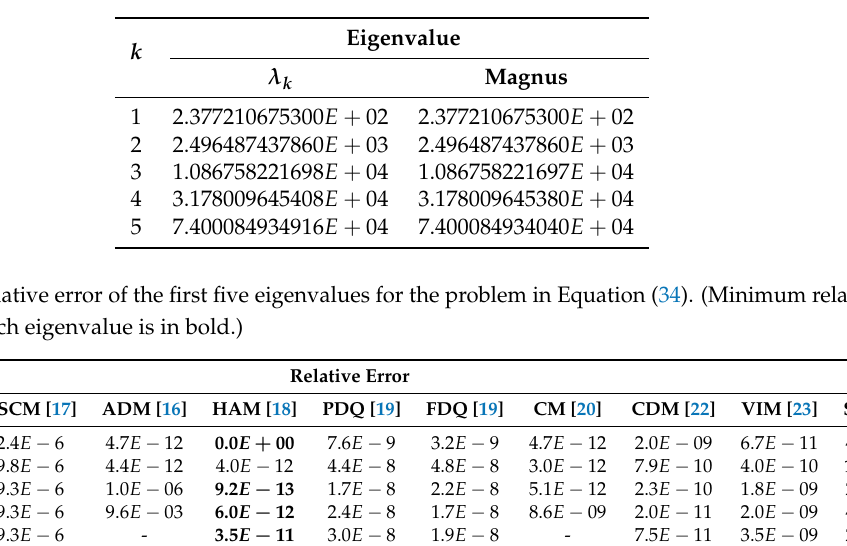
Table 7. The first five eigenvalues of the problem in Equation (34).